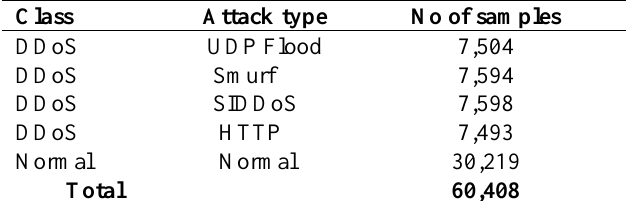
Table 3. Distribution of DDoS Attack and Normal